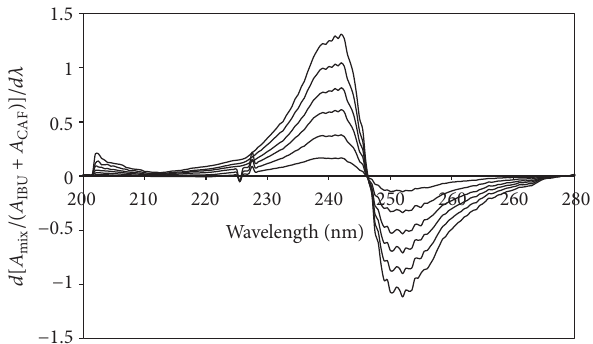
F 4: First-derivative double divisor-ratio spectra for a ternary mixture of aspirin, caffeine, and paracetamol aer simultaneous standard addition of three components in the concentration range